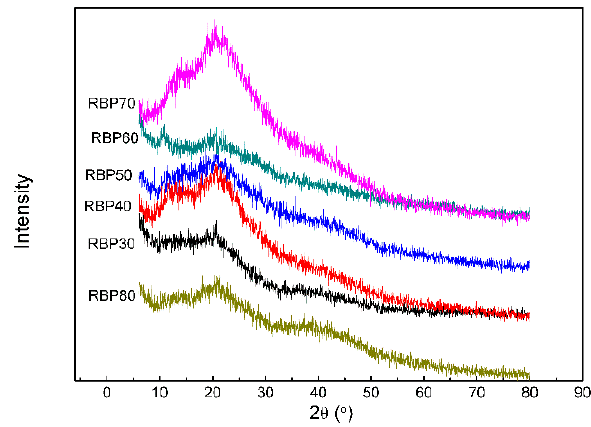
Figure 7. XRD curves of RBPs. F igure 7. XRD curves of RBPs.